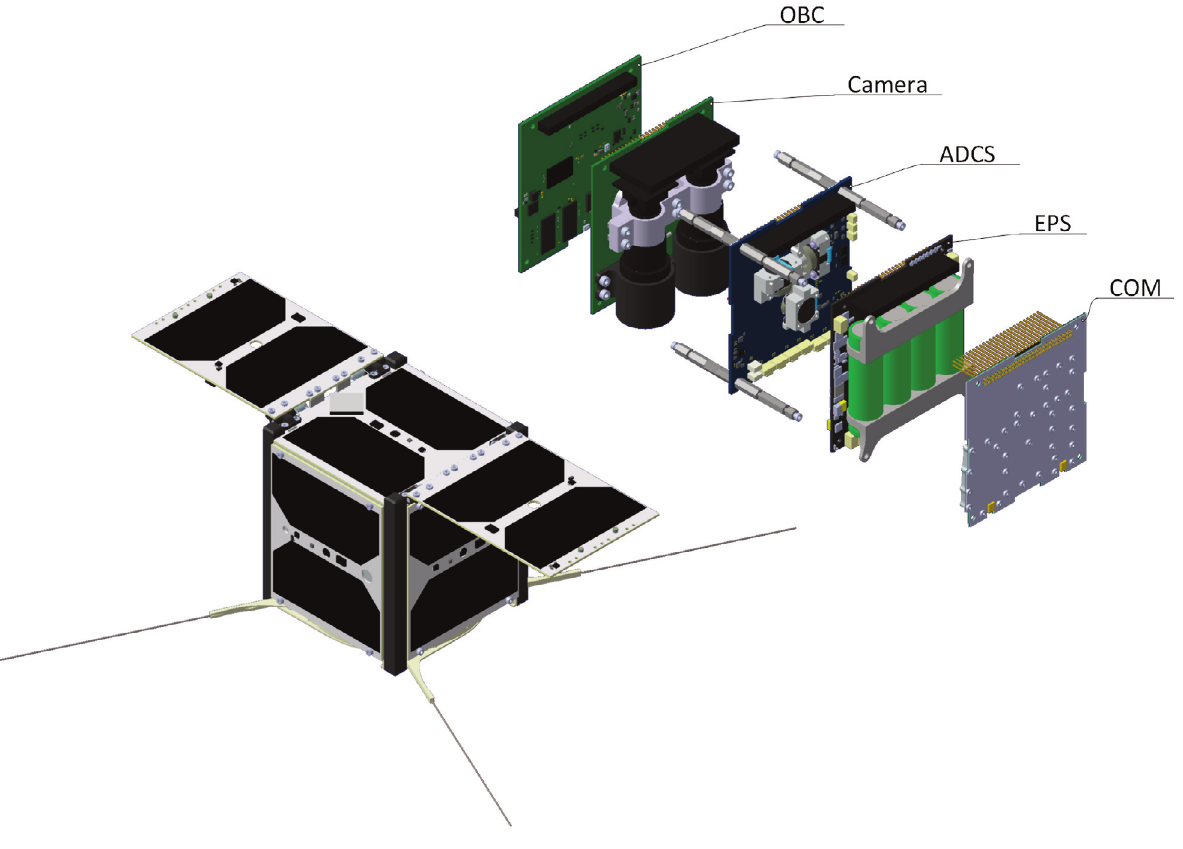
Fig. 2. Representation of the TTU100 satellite and its main components: OBC (On-Board Computer), ADCS (Attitude Determination and Control System), EPS (Electronic Power System), and COM (Communications)